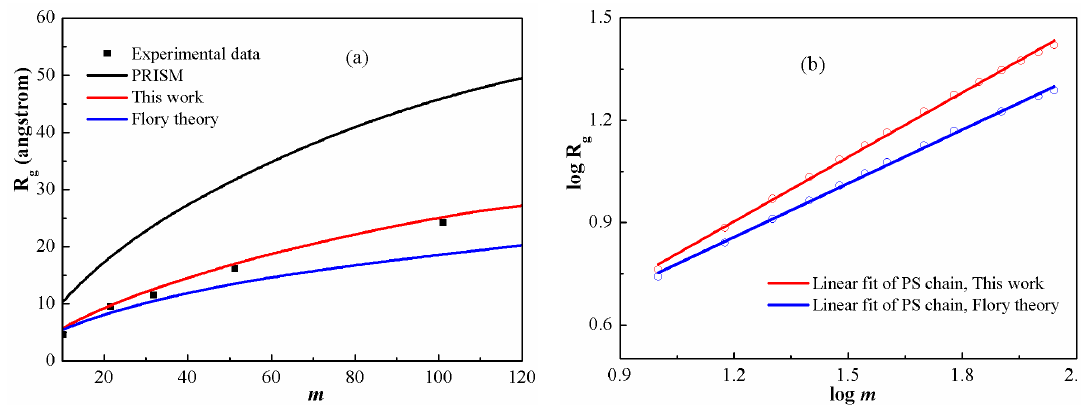
Figure 3. ( a ) Gyration radius as a function of chain length for PS chains at 500 K; ( b ) Determination of the scaling exponents. The circles are calculated results and the solid line is the best linear regression of the circles.